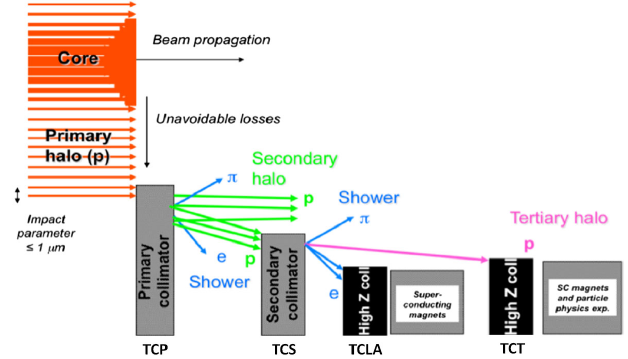
FIG. 2. Qualitative schematic diagram of the LHC multistage collimation system